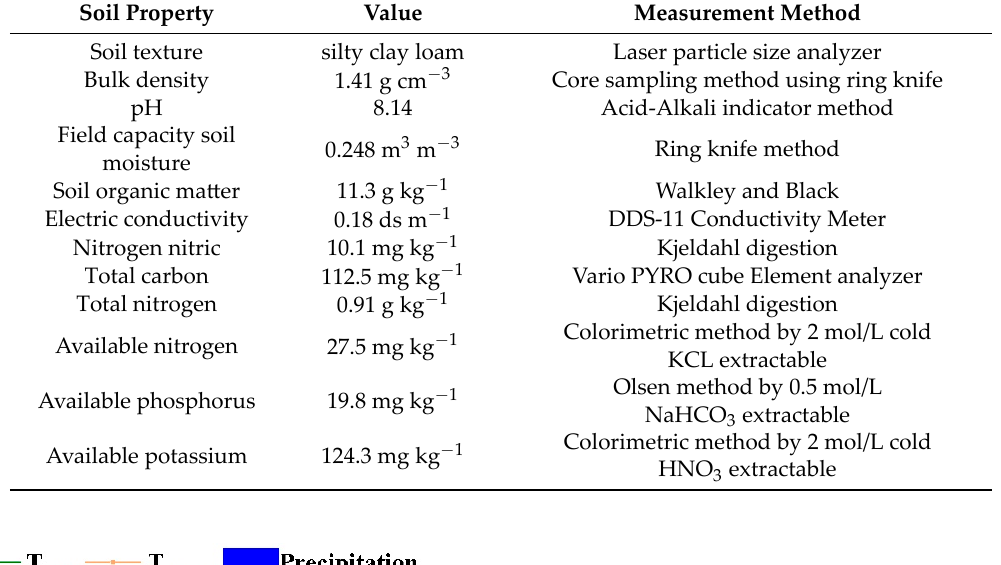
Table 1. Basic soil properties of the plough horizon soil layer at the experimental site in Yangling, China (sampled on 17 June 2021).